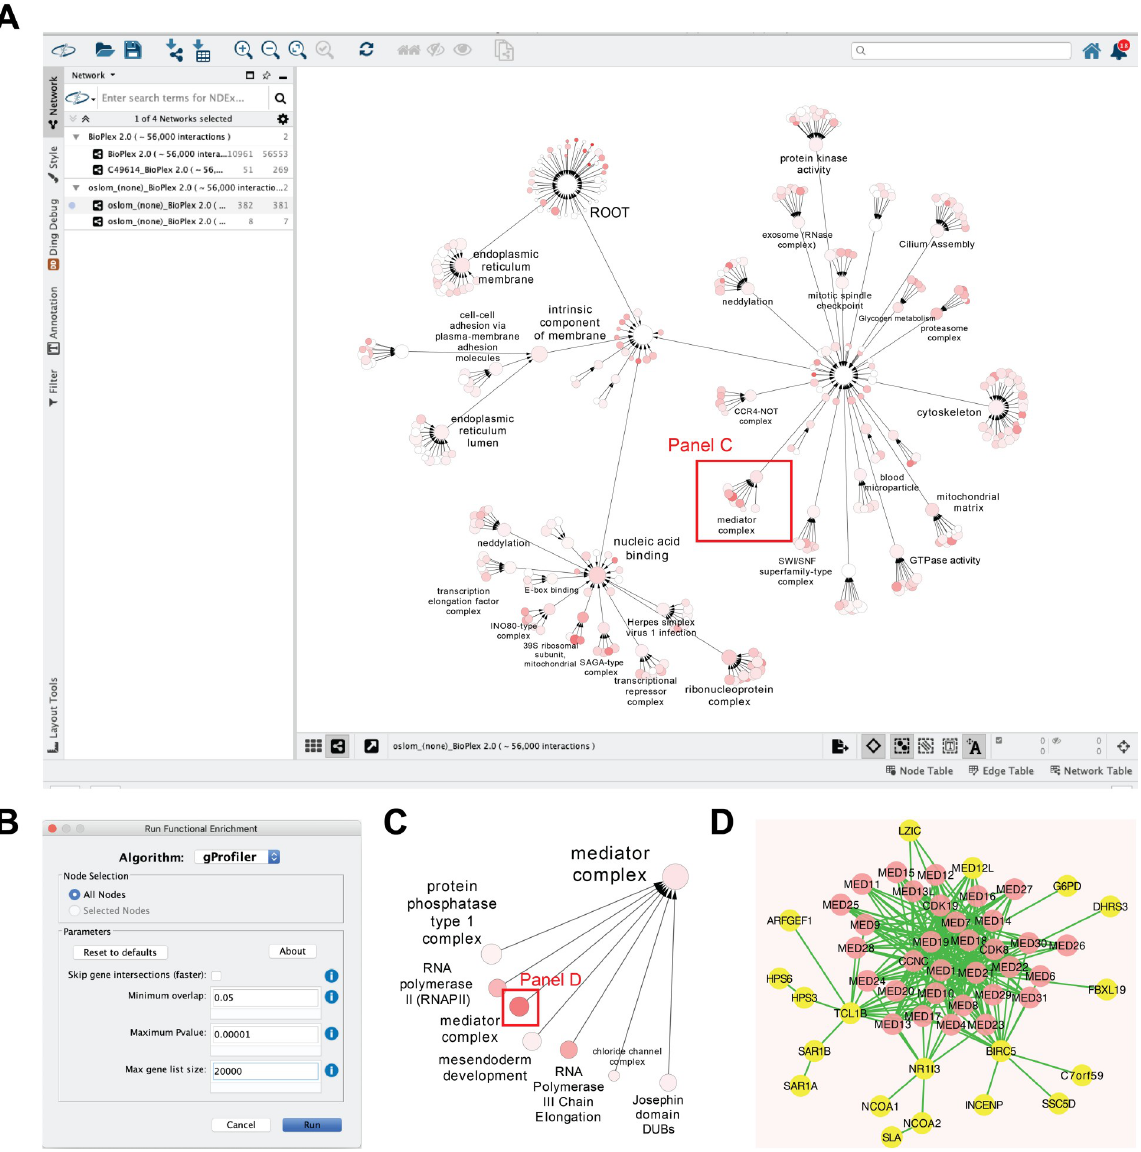
Fig 3. Results of hierarchical community detection and downstream analyses. (A) A hierarchy derived from the BioPlex 2.0 [4] interaction network with OSLOM [25] and annotated by g:Profiler. Red rectangle : a subregion in the hierarchy related to the mediator complex. (B) The menu to set up functional annotation with g:Profiler. (C) A zoom-in view of the sub-hierarchy highlighted in panel A. Red rectangle : a community to be further explored. (D) The interaction subnetwork of the community highlighted in panel C. Proteins, not known as members of the mediator complex, are highlighted ( yellow ). Related to steps 6–11 in the example workflow. Node color : The overlap (Jaccard Index) between a community and the gene set corresponding to its annotation (panels A and C). Networks can be found on NDEx: